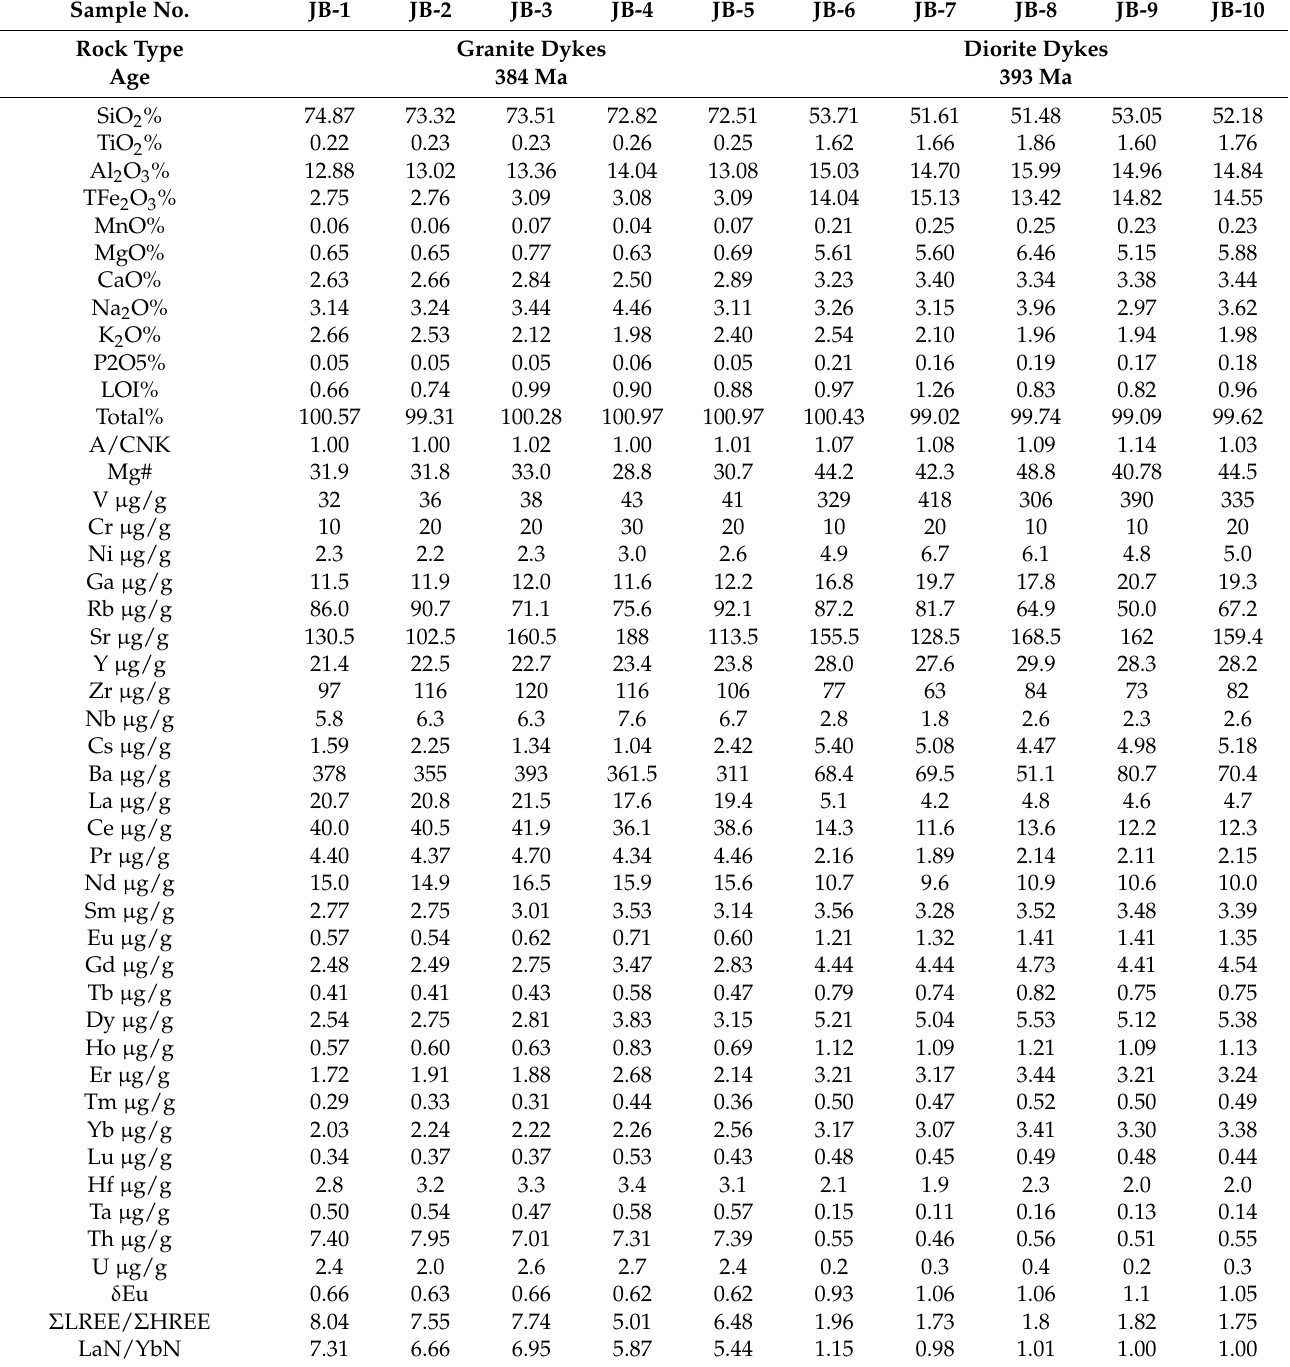
Table 3. Major (%) and trace element (ppm) data from granite and diorite dykes of the Jinba gold